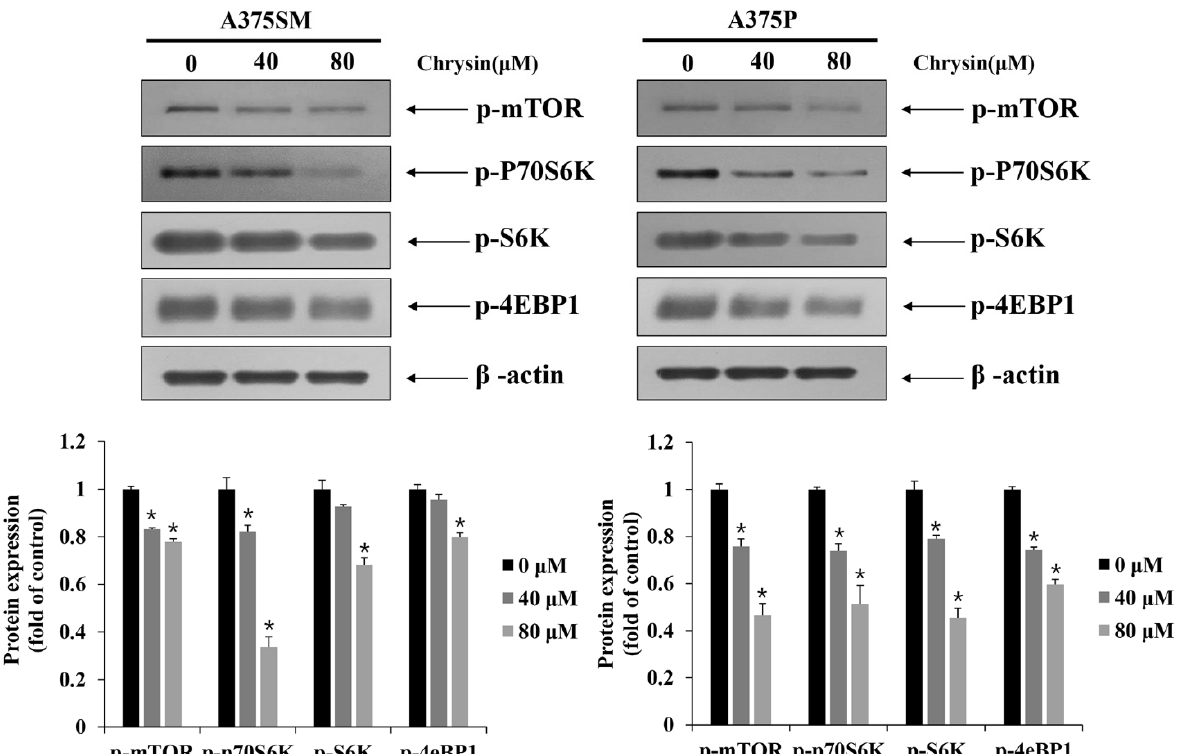
Figure 8. Chrysin inhibited the mTOR/S6K pathway in A375SM and A375P human melanoma cancer cells. Cells were treated with the indicated concentrations of chrysin and protein levels of p-mTOR, p-p70S6K, p-S6K, and p-4EBP1 were measured by Western blotting. β -actin was used as a loading control. Quantification was performed in three independent experiments using ImageJ, normalizing the intensities of the bands to the controls. Data are presented as the mean and standard deviation for three samples. Significance was determined by Student’s t -test, * p < 0.05, compared with the control.